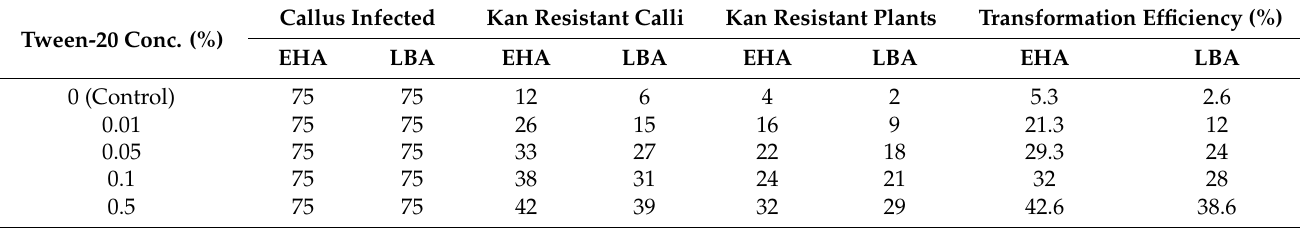
Table A6. Effect of Tween- 20 on transformation efficiency of callus derived from seeds of P.scrobiculatum L. Tween-20 Conc. (%)